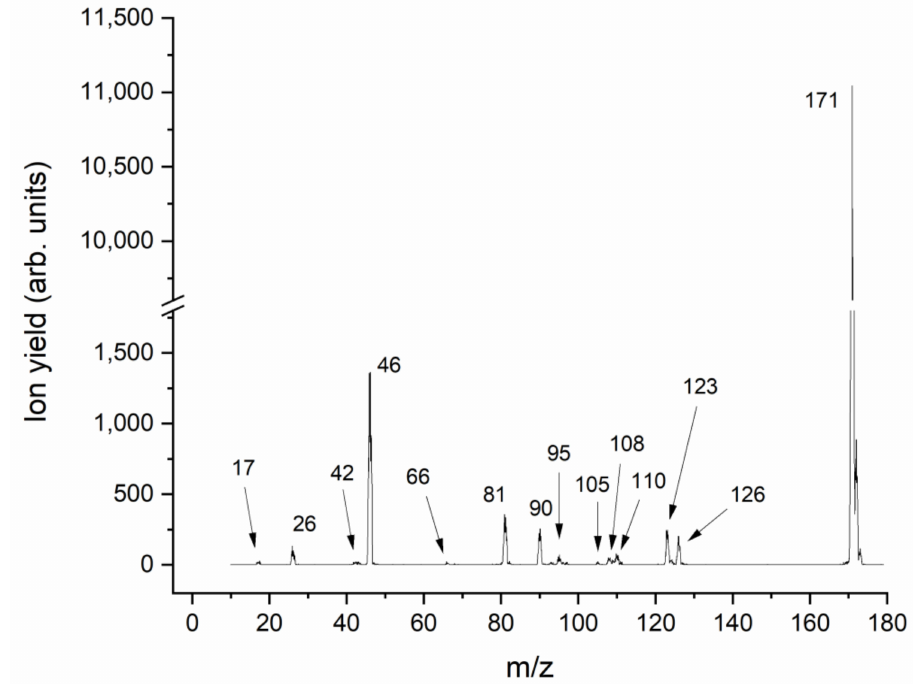
Figure 2. The negative ion mass spectrum of isolated Metro obtained by the sum of single mass spectra in the electron energy range ~0–3.75 eV in 0.25 eV steps. The mass-to-charge ratio of anions further studied by the measurement of the corresponding anion efficiency curves and quantum chemical calculations are mentioned.